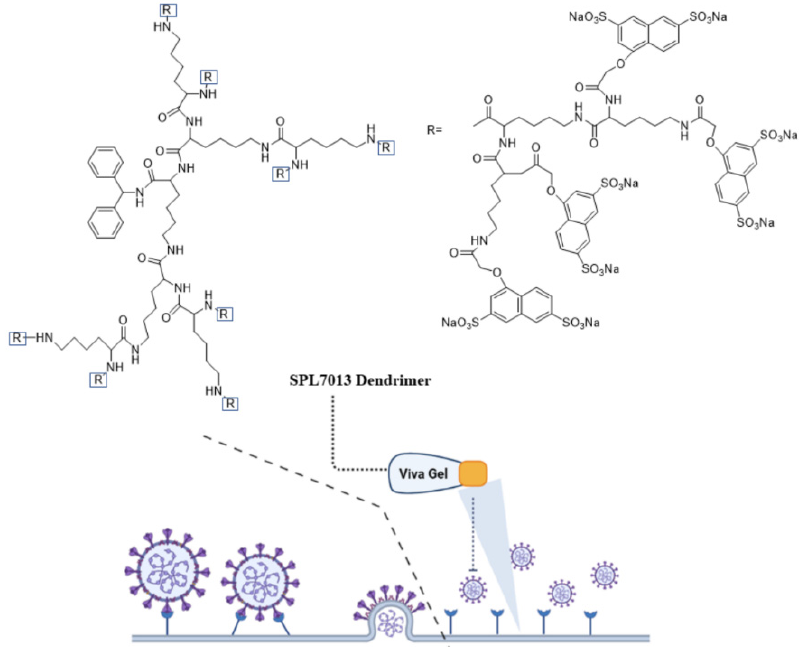
Figure 10. Chemical structure and mechanism of action of VivaGel ® as an antiviral agent. The image was created by BioRender software. was created by BioRender